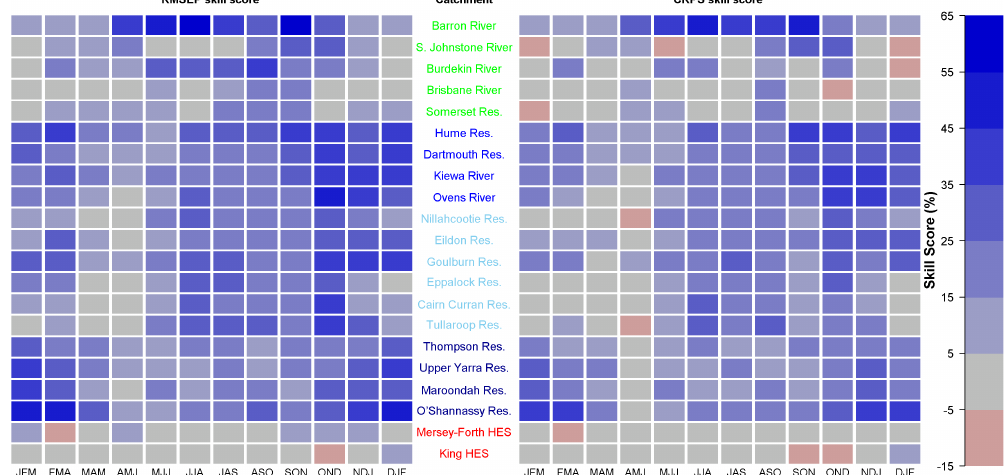
Fig. 5. Skill scores of the cross-validation forecasts made using WAPABA simulations and lag-1 streamflow as predictors.